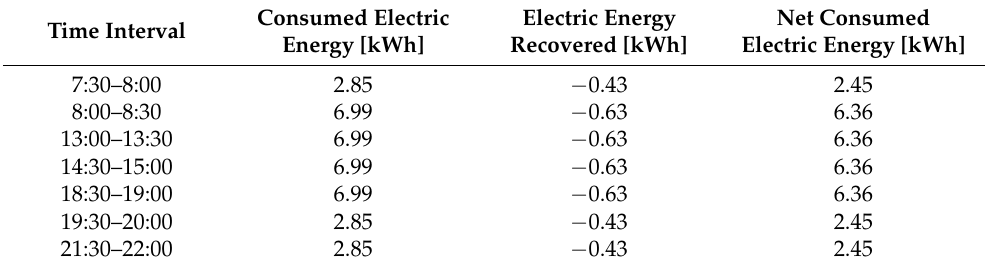
Table 11. Mobility pattern 2 energy needs.